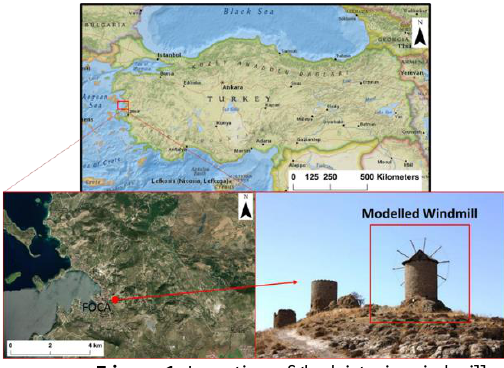
Figure 1. Location of the historic windmill.